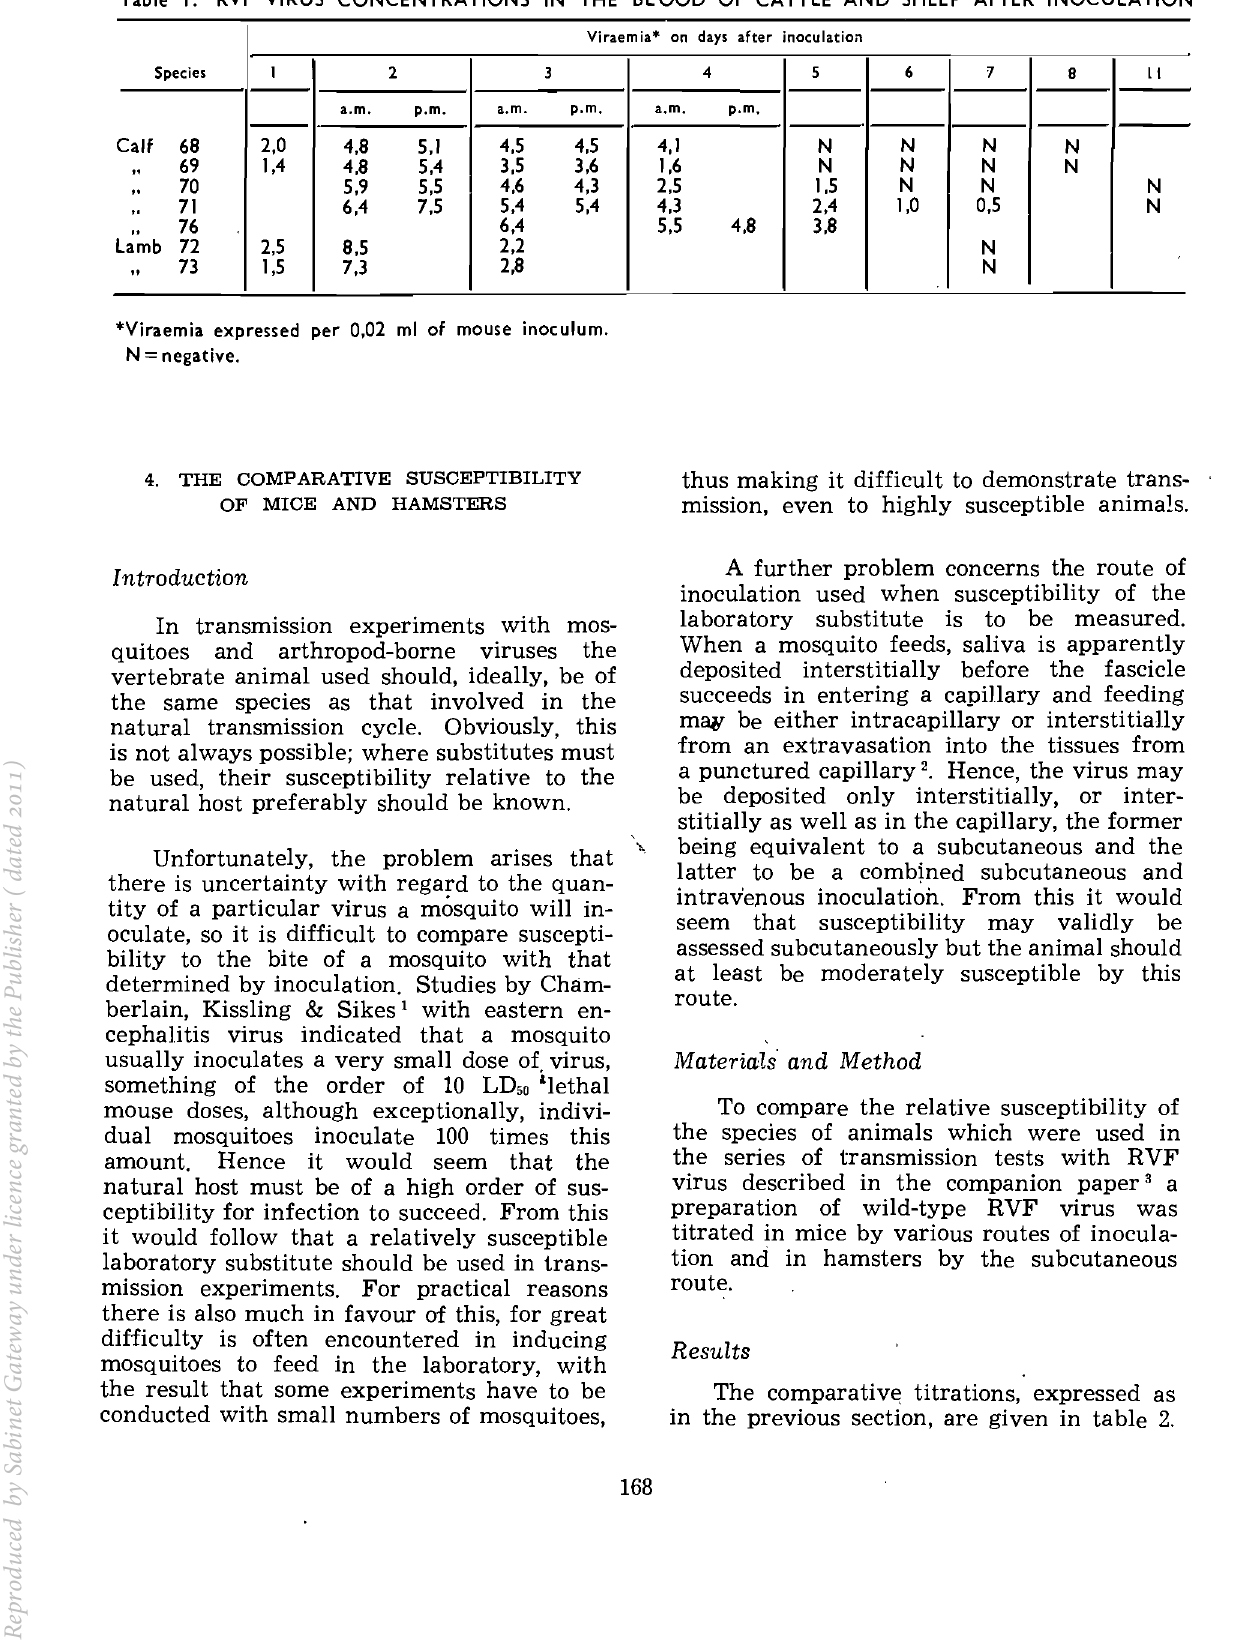
Viraemia* on days after inoculation